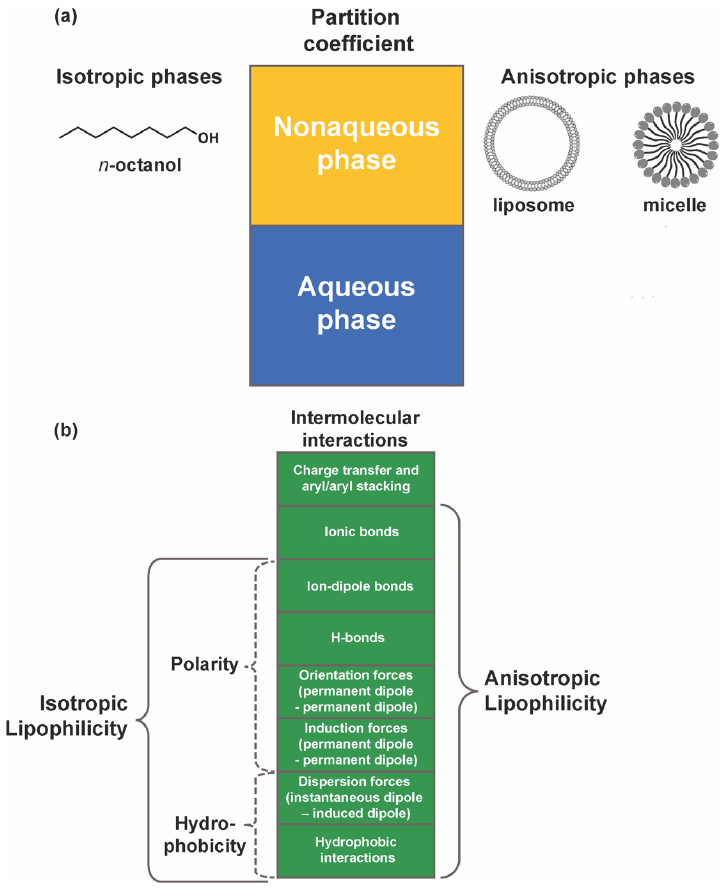
Figure 1. ( a ) Models used to determine isotropic and anisotropic lipophilicity; ( b ) forces governing intermolecular interactions between drugs and biological systems and their relationship with isotropic and anisotropic lipophilicity.